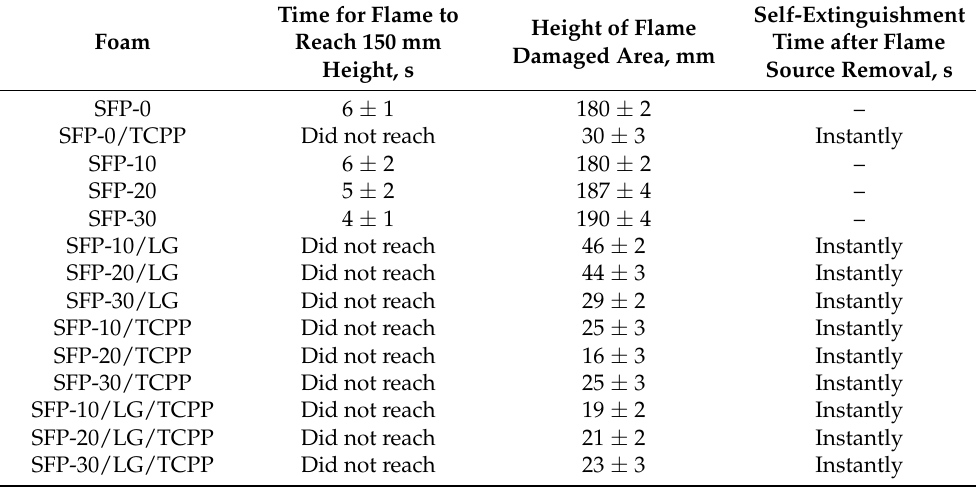
Table 4. Ignitability test results of PUR and flame retardant PUR